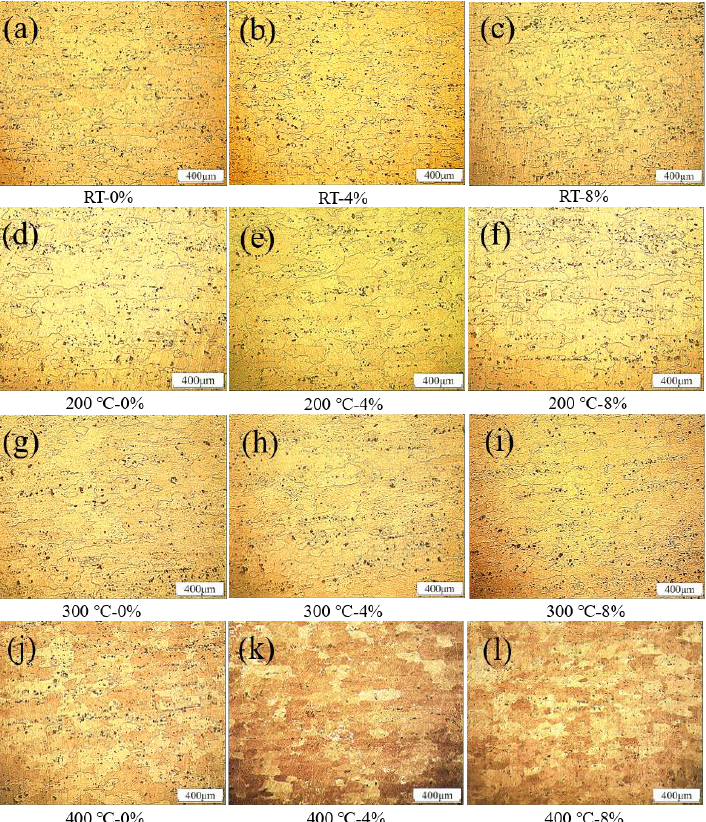
Figure 2. Metallographic structure of 2A12-T4 aluminum alloy under the thermal strain condition. ( a ) Room temperature untreated, E.g. base material; ( b ) 4% pre-strain was given at room temperature; ( c ) 8% pre-strain was given at room temperature; ( d ) Without strain under peak temperature of 200 ℃ ; ( e ) 4% pre-strain was given at peak temperature of 200 ℃ ; ( f ) 8% pre-strain was given at peak temperature of 200 ℃ ; ( g ) Without strain under peak temperature of 300 ℃ ; (h) 4% pre-strain was given at peak temperature of 300 ℃ ; ( i ) 8% pre-strain was given at peak temperature of 300 ℃ ; ( j ) Without strain under peak temperature of 400 ℃ ; ( k ) 4% pre-strain was given at peak temperature of 400 ℃ ; ( l ) 8% pre-strain was given at peak temperature of 400 ℃ . Table 2. Grain size under the thermal strain condition.